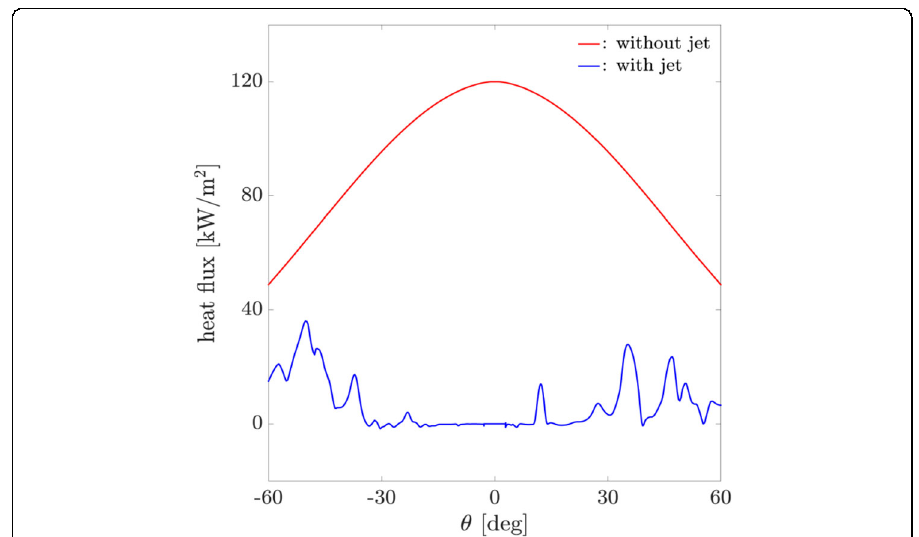
Fig. 5 The distribution of the heat flux along the cylinder corresponding to the temperature field shown in Fig. 4. The result in the case without jet (red) is also depicted for